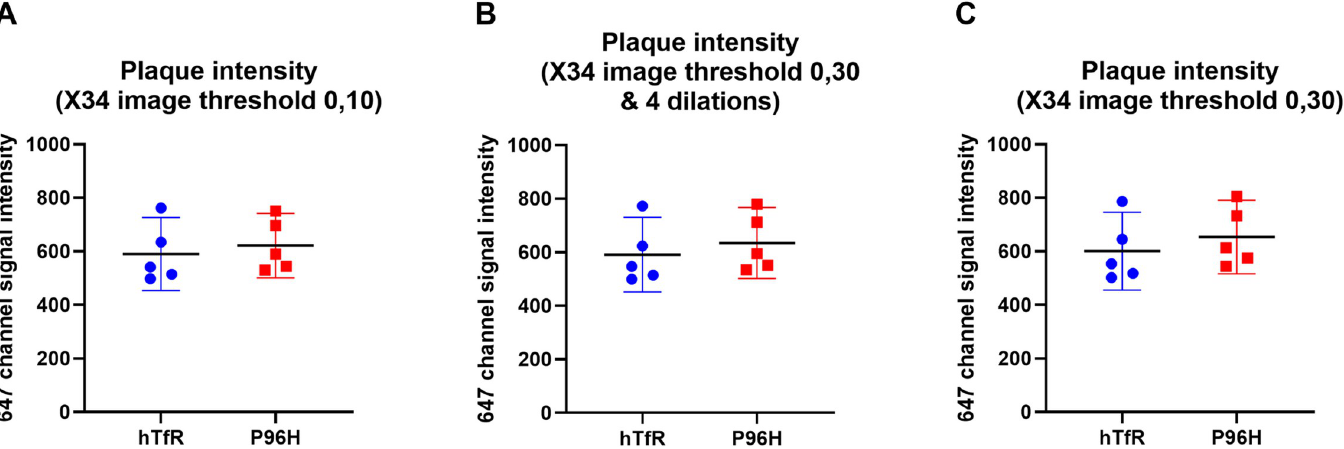
Fig 10. Averaged mean fluorescence in the 647 channel of plaques containing regions. ( A ) The threshold for X34 images was set to be at (0, 10) There was no significant difference between the mean signals from mice injected with H1-triplet-647 and mice injected with M1 P96H -triplet-647; unpaired student t-test, p = 0.6404. ( B ) The threshold for X34 images was set to be at (0, 30), then the image was eroded for four times. There was no significant difference between the mean signals from mice injected with H1-triplet-647 and mice injected with M1 P96H -triplet-647; unpaired student t-test, p = 0.5527. ( C ) The threshold for X34 images was set to be at (0, 30). There was no significant difference between the mean signals from mice injected with H1-triplet-647 and mice injected with M1 P96H -triplet-647; unpaired student t-test, p = 0.4829.